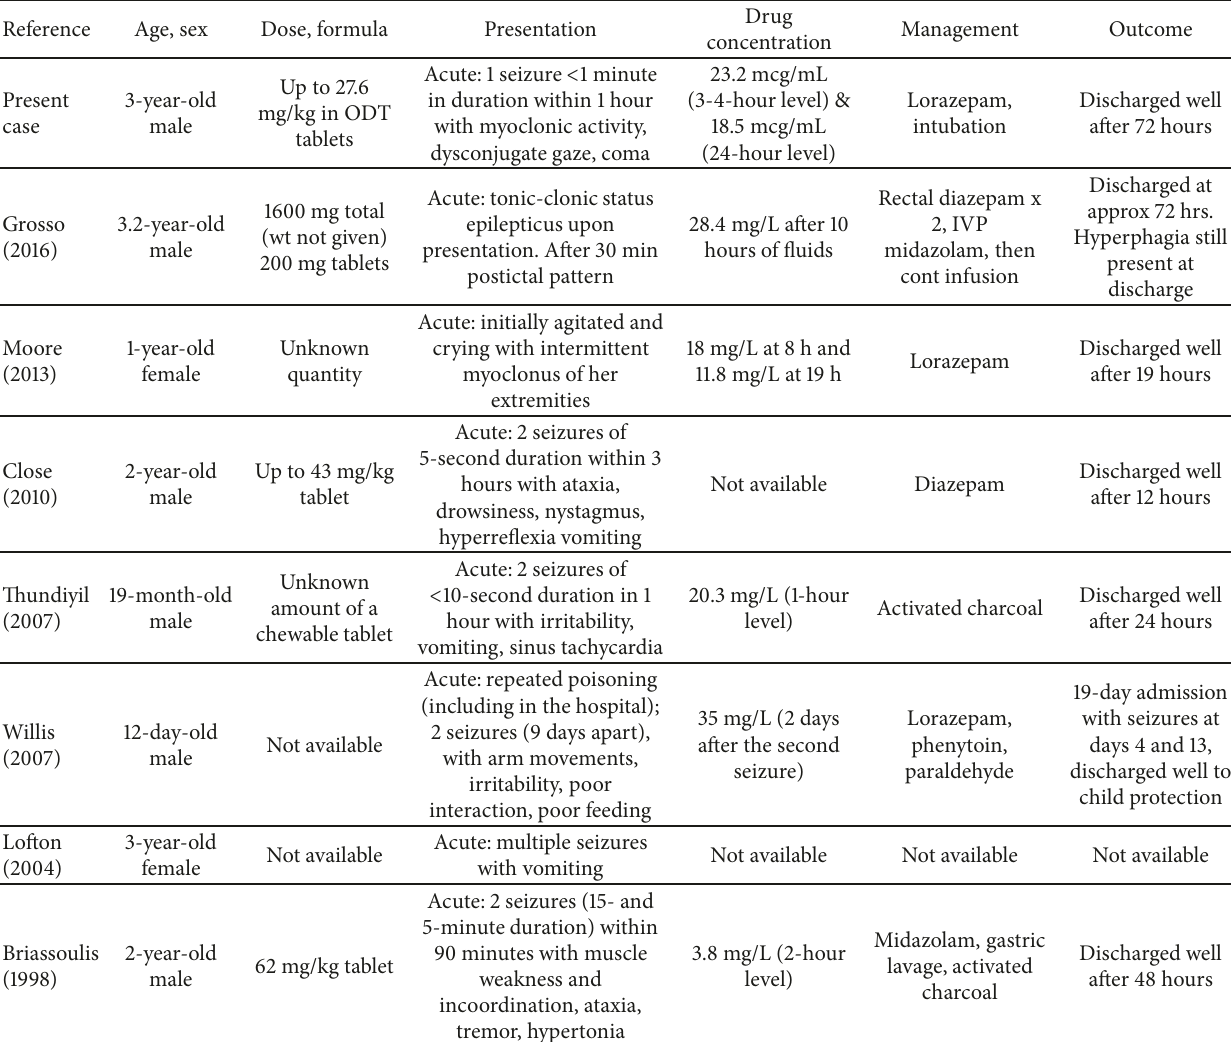
Table 1: Case reports of pediatric seizures following lamotrigine